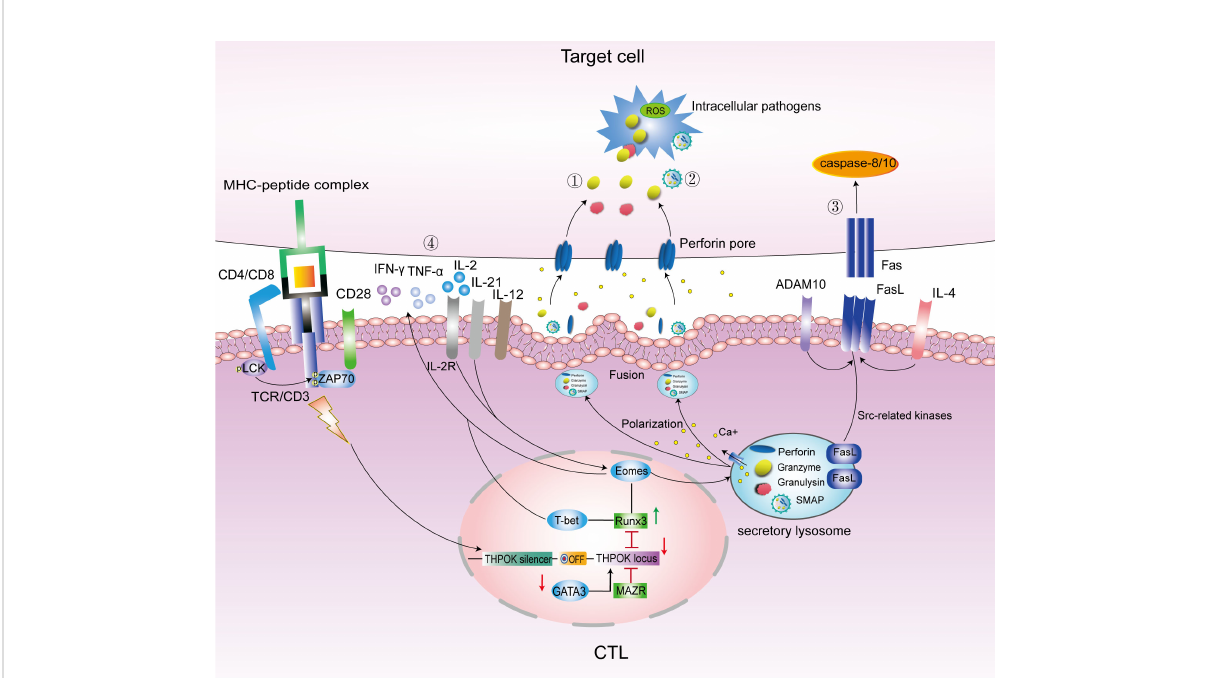
FIGURE 1 Main pathways to kill intracellular bacteria by CTLs. Under the regulation of transcription factors GATA3/THPOK/Runx3, CD4/CD8 T cells differentiate into CD4/CD8 CTLs. Eomes and T-bet promote the secretion of cytotoxic granules contents PFN, Gzm and GNLY, and IFN- g to kill target cells. The main pathways to kill intracellular bacteria included the following: ① .PFN/GNLY/GzmB-mediated cytotoxic granules pathway; ② .SMAPs pathway; ③ . Fas-FasL cell apoptosis pathway; and ④ . Cytokine pathway mainly include IFN- g , TNF- a , IL-12, IL-21and IL-4. LAMP, lysosome-associated membrane glycoprotein; ThPOK, T-helper inducing POZ-Kruppel-like factor; Runx3, Runt-related transcription factor 3; Eomes, Eomesodermin; MAZR, POZ/BTB and AT-hook-containing zinc fi nger protein 1; ADAM10, A Disintegrin And Metalloproteinase 10; PFN, perforin; Gzm, granzyme; FasL, Fas ligand; SMAPs, supramolecular attack